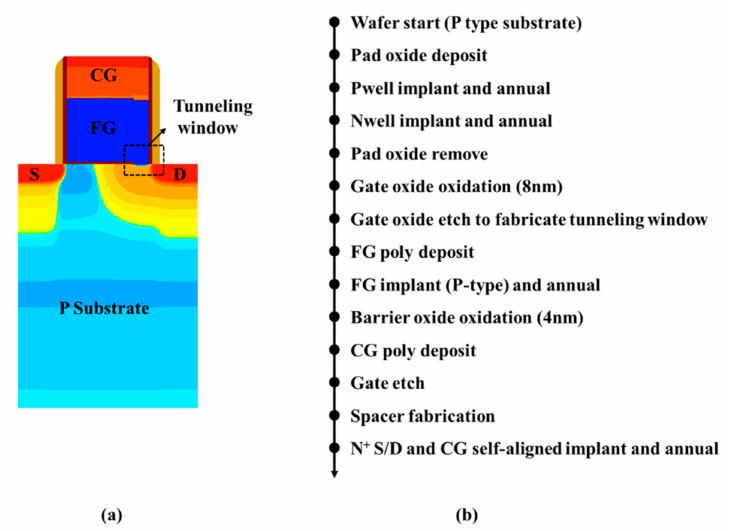
Figure 1. ( a ) The device structure with concentration profile and ( b ) the main process flow of